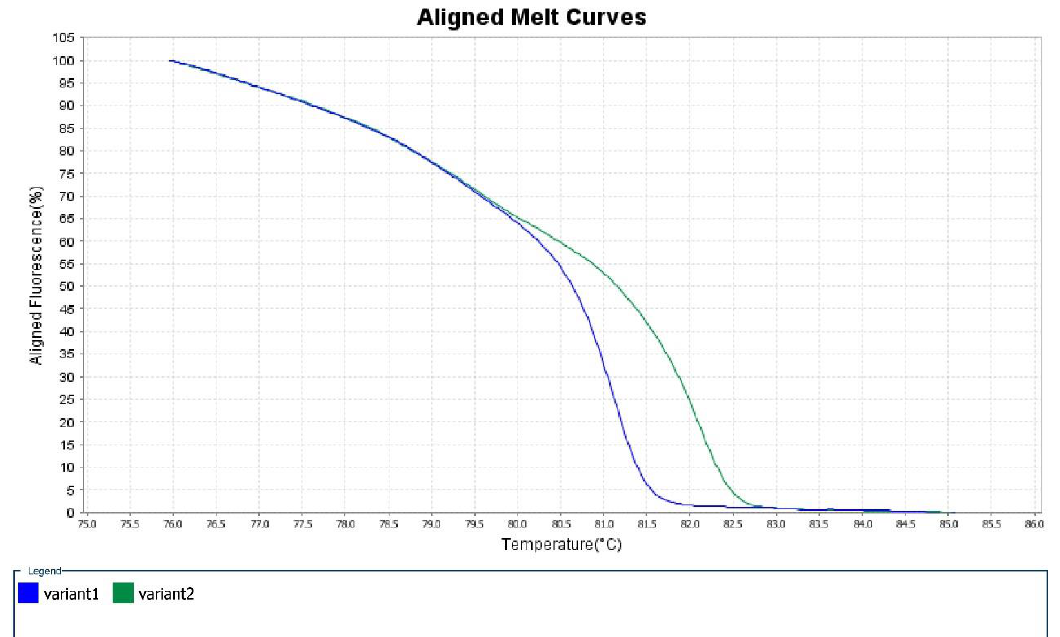
Figure 2. Aligned melt curves of OXA-48 (blue) and OXA-232/OXA-181 (green).